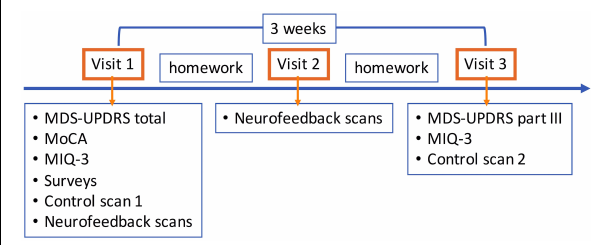
FIGURE 2 | Neurofeedback study flow. Visit 1 consisted of clinical assessments and self-evaluation surveys, motor imagery strategy development session, first control scan without neurofeedback, and neurofeedback scans (4–5). Successful motor imagery strategies during neurofeedback training were assigned as motor imagery homework, and subjects were provided diaries to keep a log. Only neurofeedback scans (6–7) were performed in visit 2. Subjects were again assigned motor imagery homework. In visit 3, MDS-UPDRS part III and MIQ-3 were repeated and the second control scan without neurofeedback was performed. The time between the first and last visits was on average 3 weeks. MDS-UPDRS, Movement Disorders Society Unified Parkinson’s Disease Rating Scale; III, Part III motor exam; MIQ-3, Movement Imagery